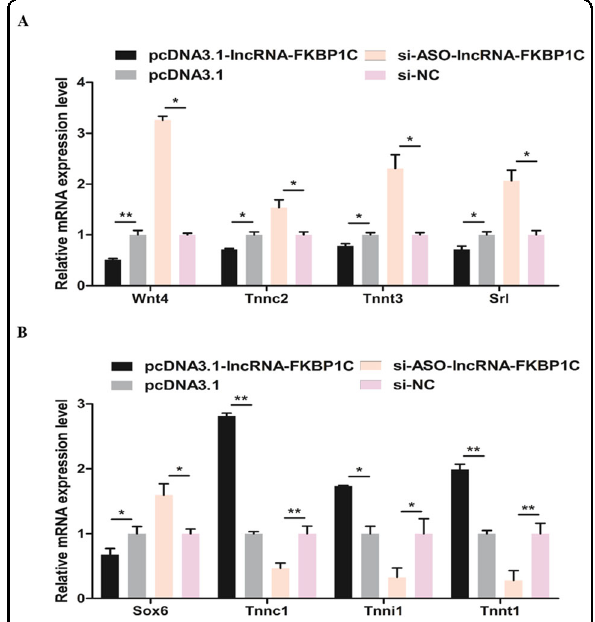
Fig. 4 LncRNA-FKBP1C participates in the formation of skeletal muscle fi bers. A, B The relative expression of several fast muscle genes and slow muscle genes induced by lncRNA-FKBP1C overexpression and interference in CPM cells. Results are shown as mean ± S.E.M. and the data are representative of at least three independent assays. Independent sample t -test was used to analyze the statistical differences between groups (* P < 0.05, ** P <